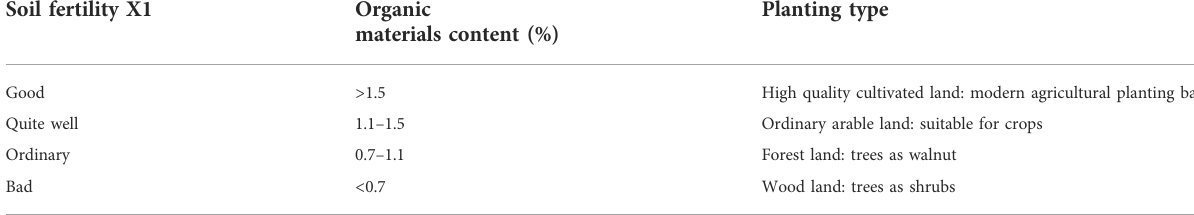
TABLE 2 The soil fertility grading and planting type.